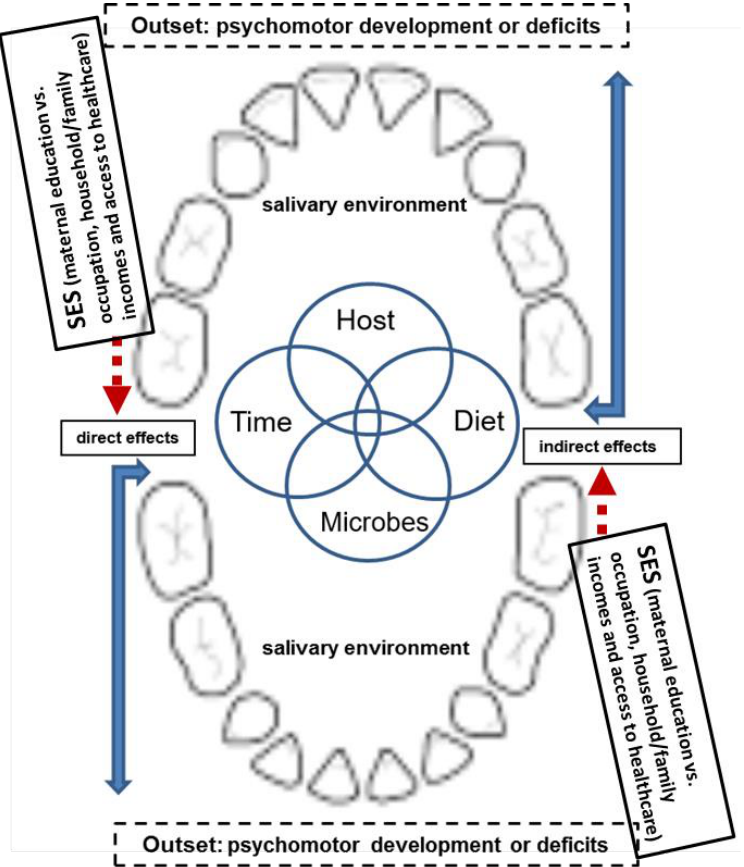
Figure 1. The SES is edited into the hypothetical framework of ECC-Psychomotor (development) axis proposed. Note: The SES is herein edited into the new hypothesis as we proposed recently (please refer to ref. [12]), where the content gradients of SES (i.e., the parental backgrounds, family incomes and access to healthcare facilities) are integrated during the initiation or progression of ECC caries (via dmft), in